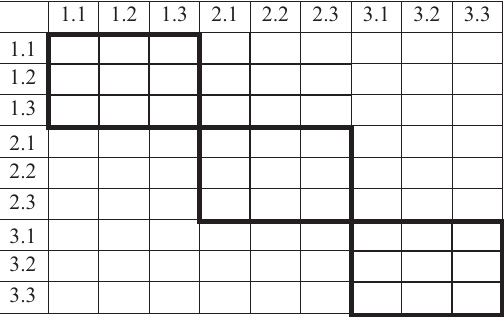
FIG. 2. Example of expert matrix used for